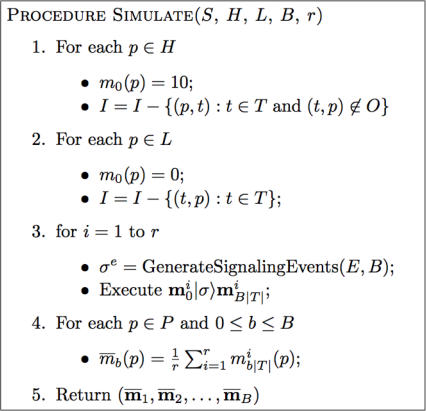
The Procedure for Simulating a Signaling Petri Net.Simulate predicts the signal flow through the SPN S. The simulation is run for B time blocks; the results of r runs are averaged to produce the final result. Most of the work is done by the signaling Petri net execution procedure detailed in the preceding sections. This execution actually performs an individual run. This procedure takes the initial marking, m0, and applies the sequence of transitions triggered by the event sequence, σe. This ordering, generated by the algorithm in Figure 6, has the dual time structure in which each block of edges contains every event in E exactly once. Each firing evaluates the effect of one transition. The markings at the end of each time block are extracted in Step 5.